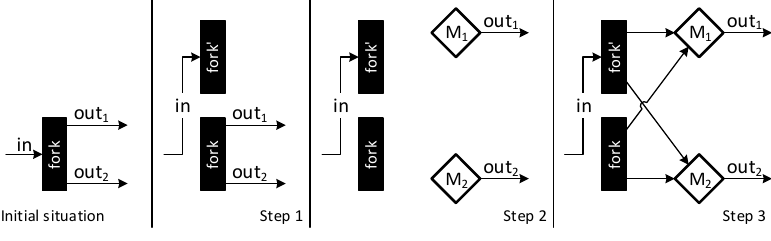
Figure 17. Steps for duplicating a fork node to preserve paths via the incoming edge